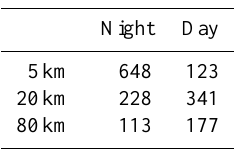
Table 2. Number of unique 5, 20, and 80km layers used in this